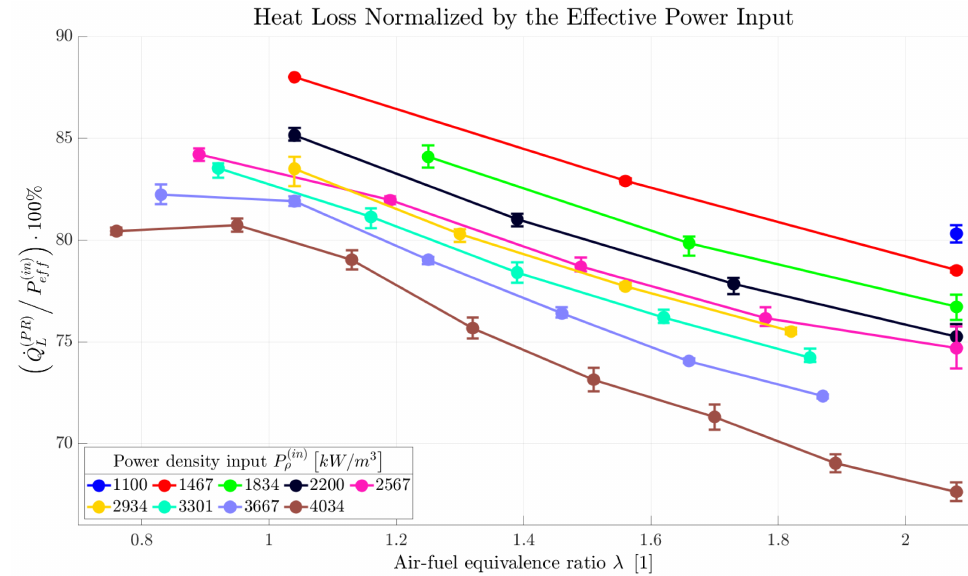
Figure 16. Total pulsation reactor heat loss normalized by the effective power input displayed relative to air–fuel equivalence ratio for several power density input